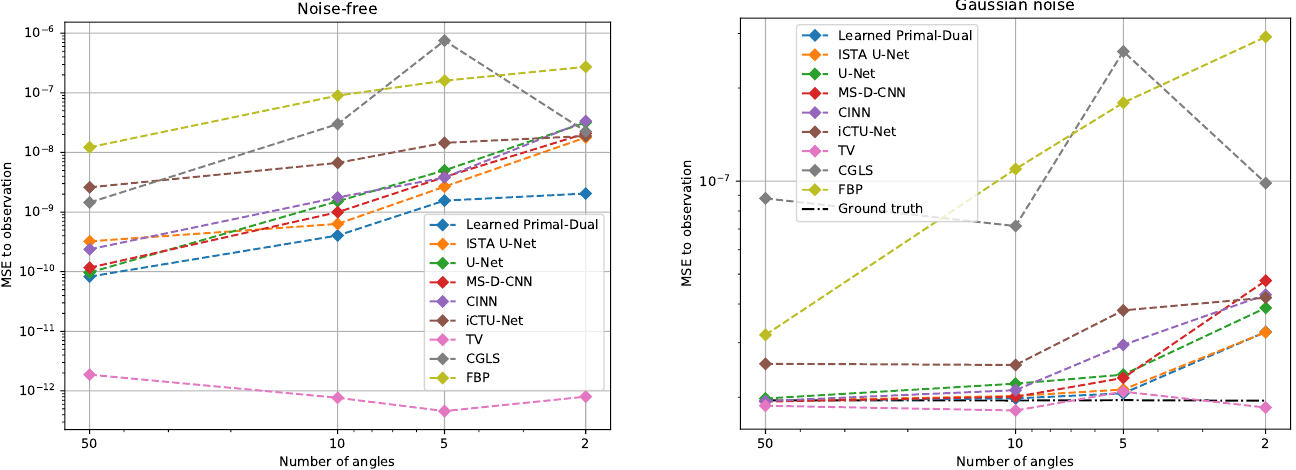
Figure 7. Mean squared error (MSE) data discrepancy between the measurements and the forward-projected reconstructions for the noise-free ( left ) and Gaussian noise ( right ) dataset. The MSE values are plotted against the number of angles used for the reconstruction. For the Gaussian dataset, the mean data discrepancy between noisy and noise-free measurements is given for reference. Evaluation is done on 100 Apple CT test images. See Table A6 for the exact